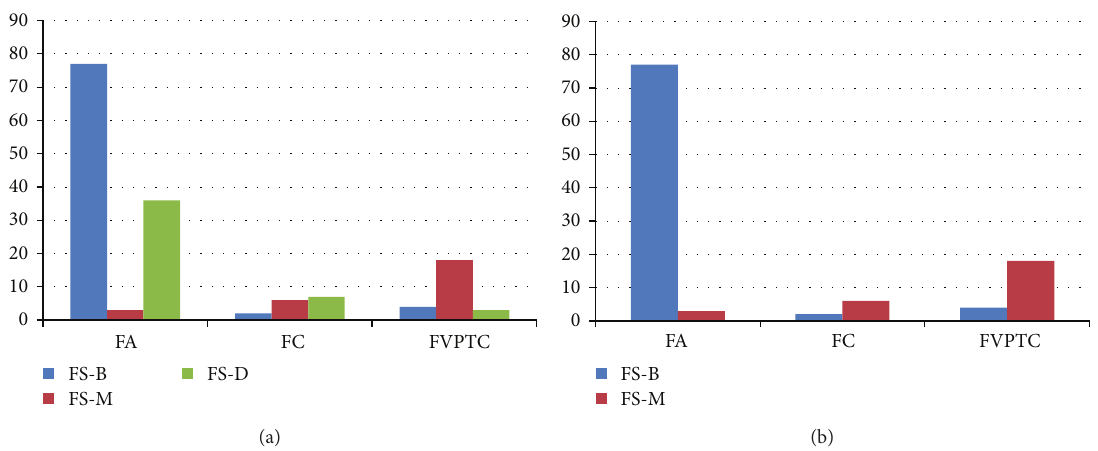
Figure 2: Results of intraoperative frozen section of the 231 thyroid nodules. Note: numbers in image represent percentages (%).